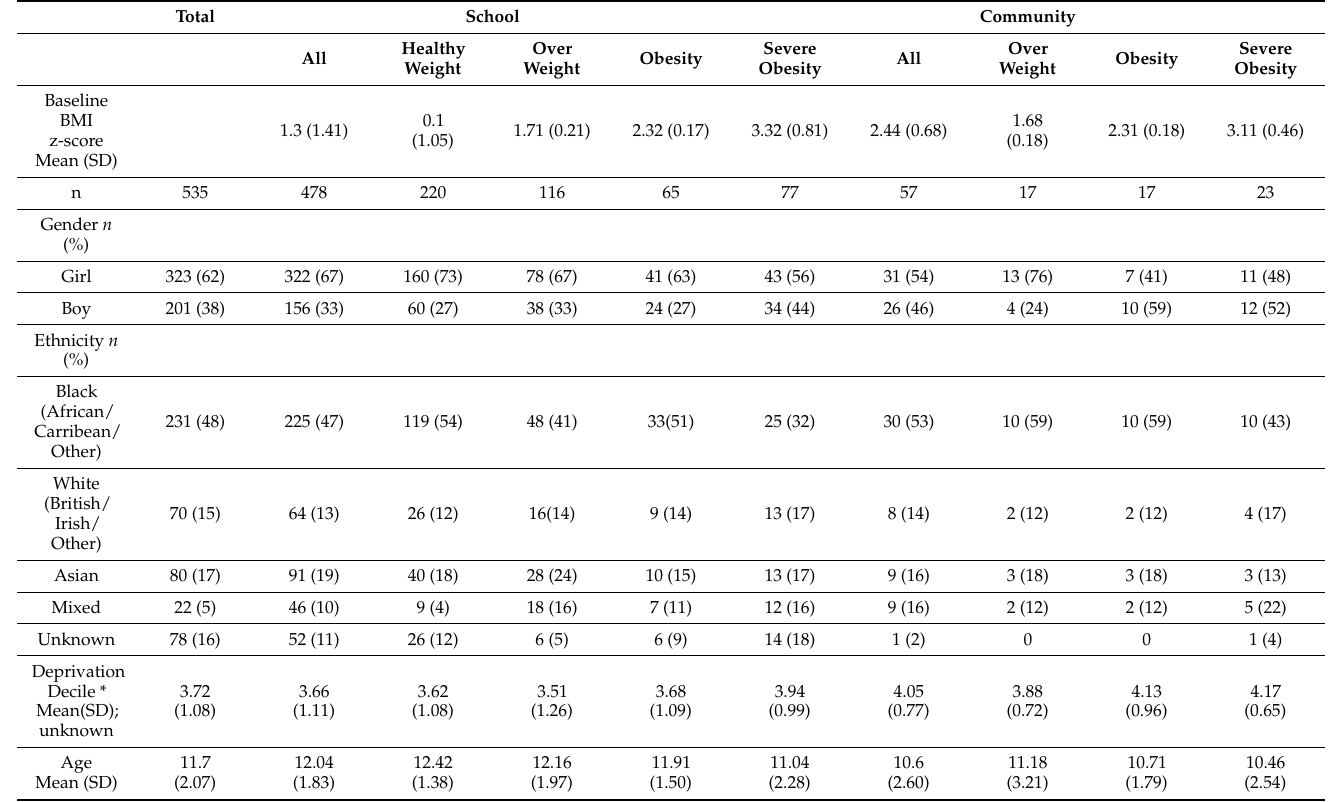
Table 2. Participant characteristics at baseline.